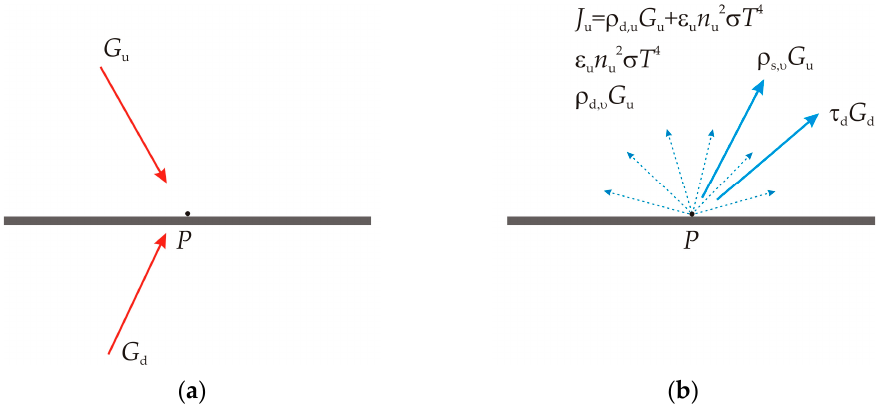
Figure 2. ( a ) Representation of upper side and lower side incoming radiation G u , G d and ( b ) upper side outgoing radiosity J u .